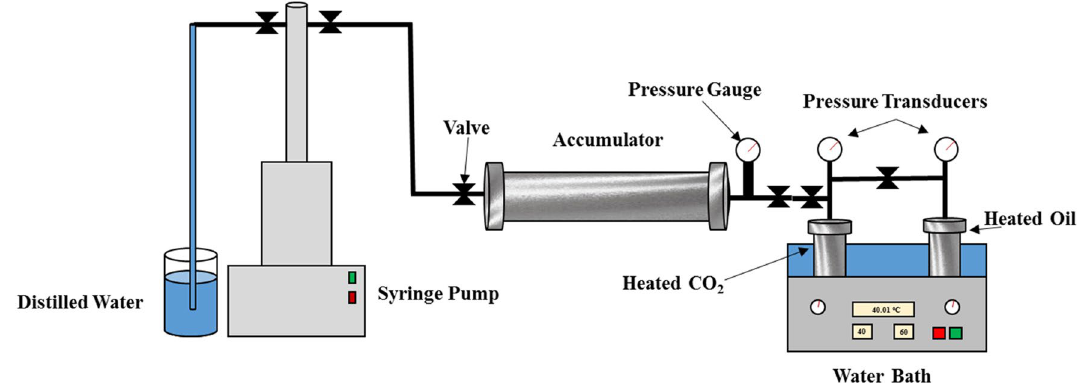
Fig. 1 Oil swelling experimental